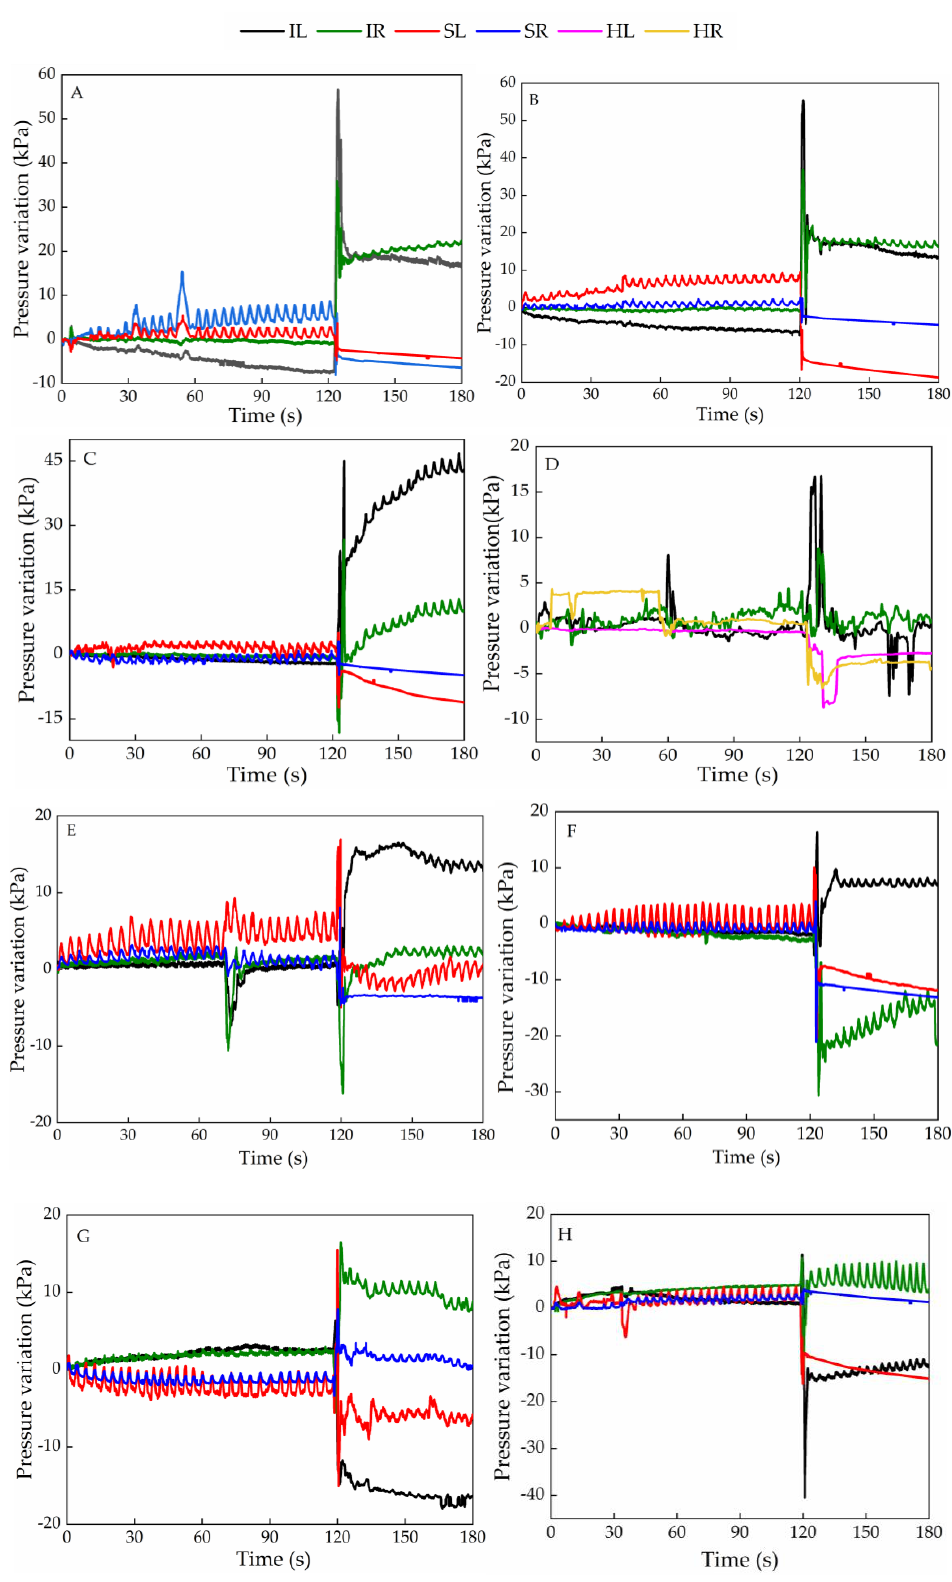
Figure 6. Pressure variation registered in di ff erent cells during the pressure relief exercises ( A – H ).